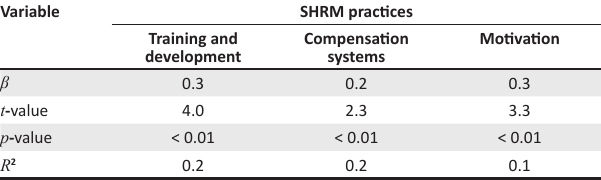
TABLE 3: Results of the regression analysis of the effect of SHRM practices and motivation, on organisational performance.